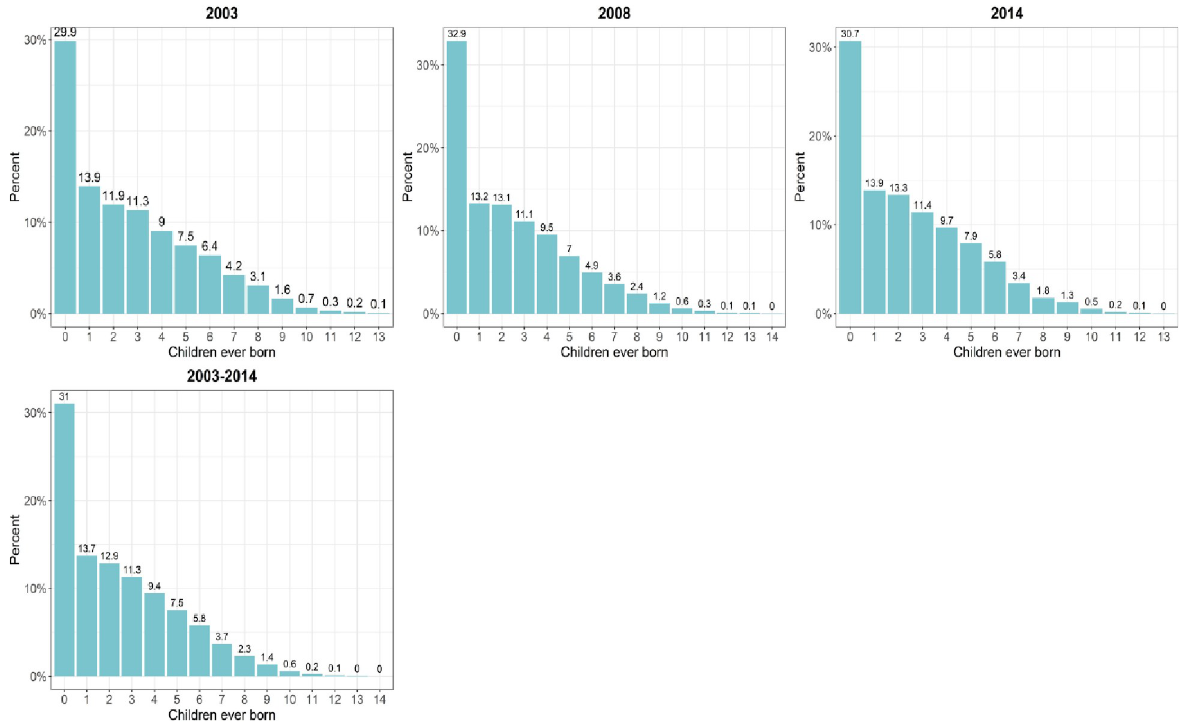
Fig 1. Cumulative fertility of women in the